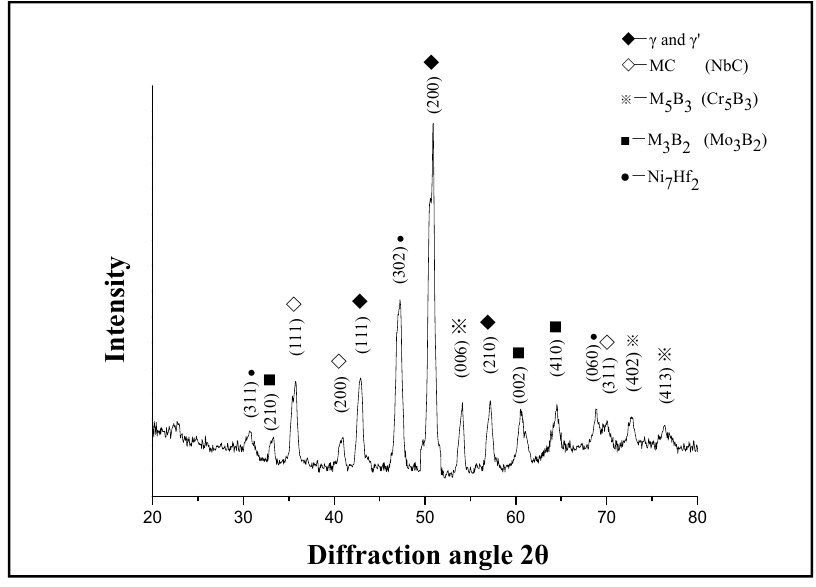
Figure 2. X-ray diffraction patterns of the cast Mar-M004 superalloy.